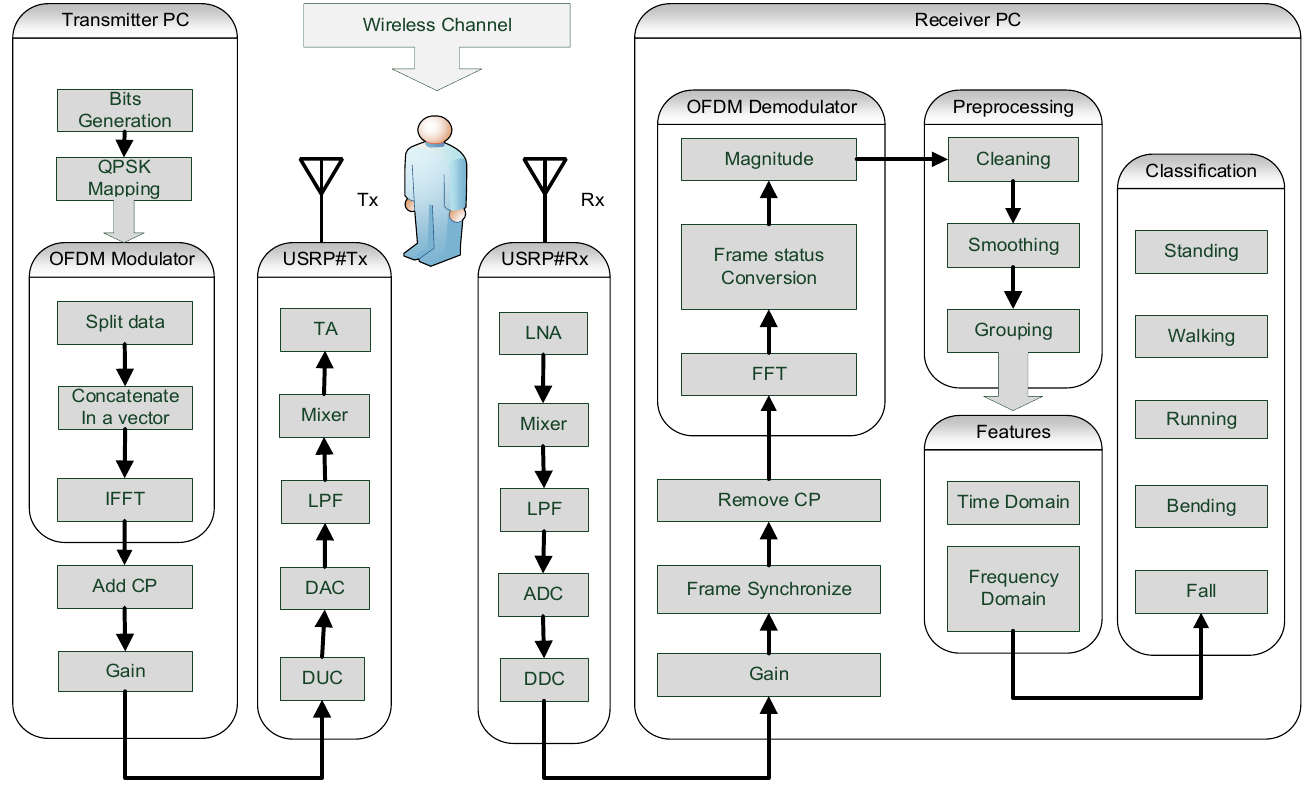
Figure 1. Non-contact smart sensing system overview. Table 2. Software-defined parameters setting of the non-contact smart sensing